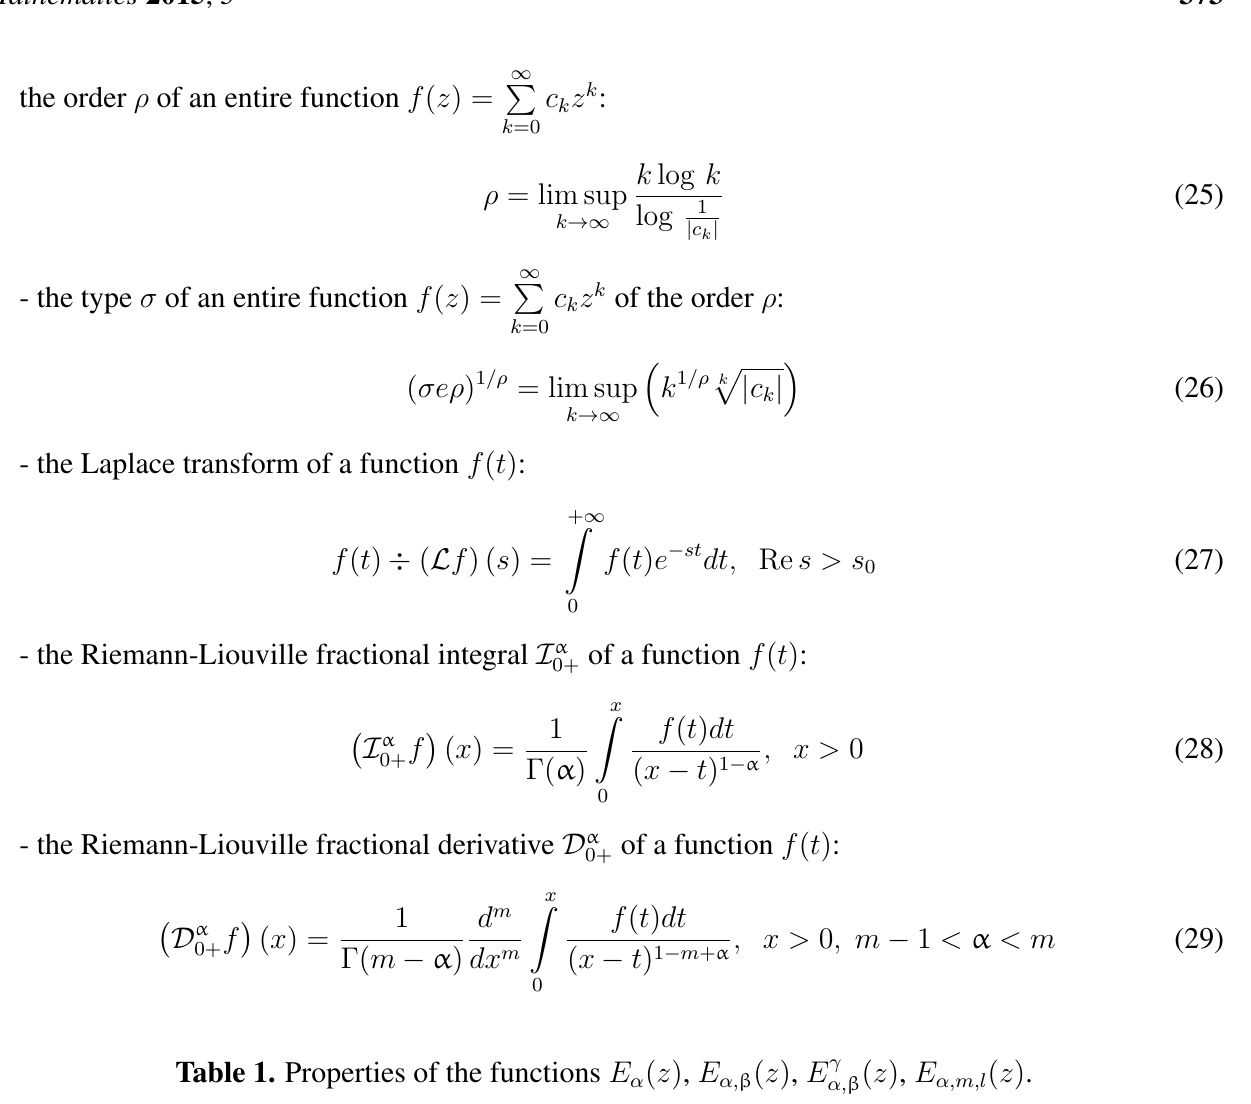
Table 1. Properties of the functions E